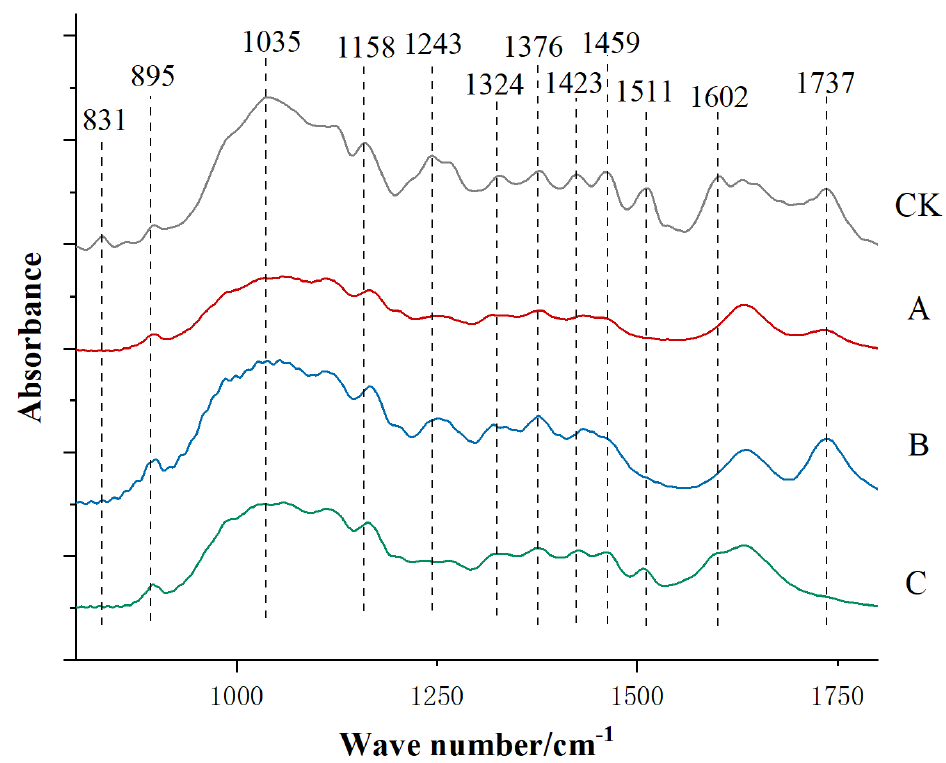
Figure 2. FTIR diagram for bamboo fiber of natural bamboo (CK) and delignified bamboos (A,B,C). Apart from the removal of lignin, the vibrational band intensity of cellulose at 1376 Table 1. Assignment of FTIR spectra absorption peaks of natural bamboo [11–13]. cm − 1 , 1324 cm − 1 , 1158 cm − 1 and 895 cm − 1 went through a small change after delignifica- tion treatment. Comparing the hemicellulose vibrational band intensity at 1737 cm − 1 and 1035 cm − 1 , it could be found that the delignification treatments of peroxyformic acid (A) and alkaline sodium sulfite (C) had a certain degree of influence on hemicellulose, which might lead to hemicellulose degradation [14], whereas acetic acid/hydrogen peroxide (B) had less of an effect on hemicellulose